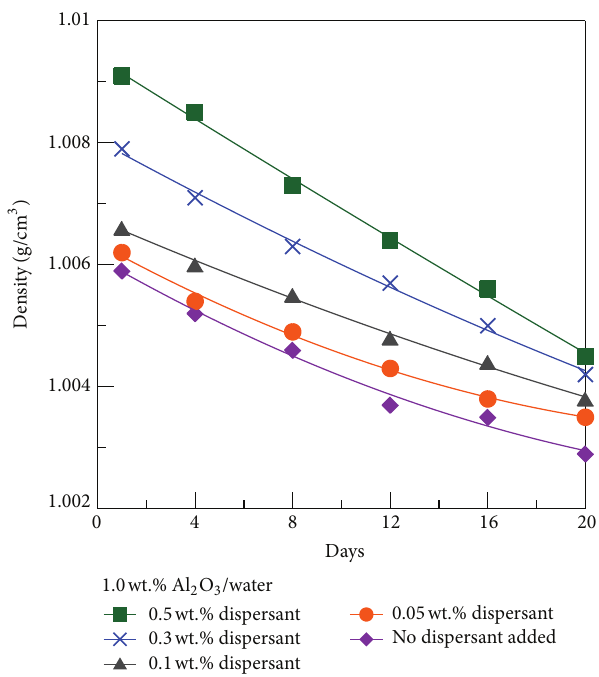
Figure 4: Correlation between weight concentration and precipita- tion behavior (1.0wt.% Al 2 O 3